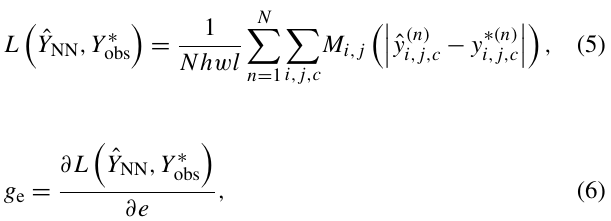
Figure 4. U-Net structure (two layers). The model structure yields a u-shaped architecture. 3 × 3 conv is a convolution function (Huang et al., 2016). P-ReLU (Huang et al., 2016) is a nonlinear activation function. Max pooling is a down sample function. Up convolution (Zeiler et al., 2010) is a deconvolution function, which is also named as up sample